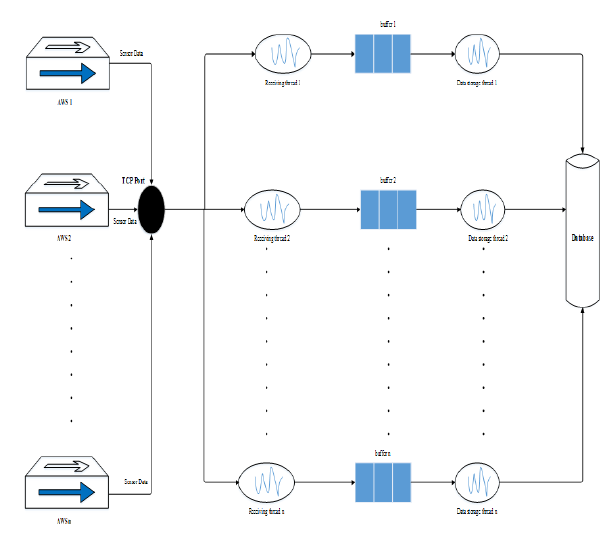
Figure 2 . Architecture of the data